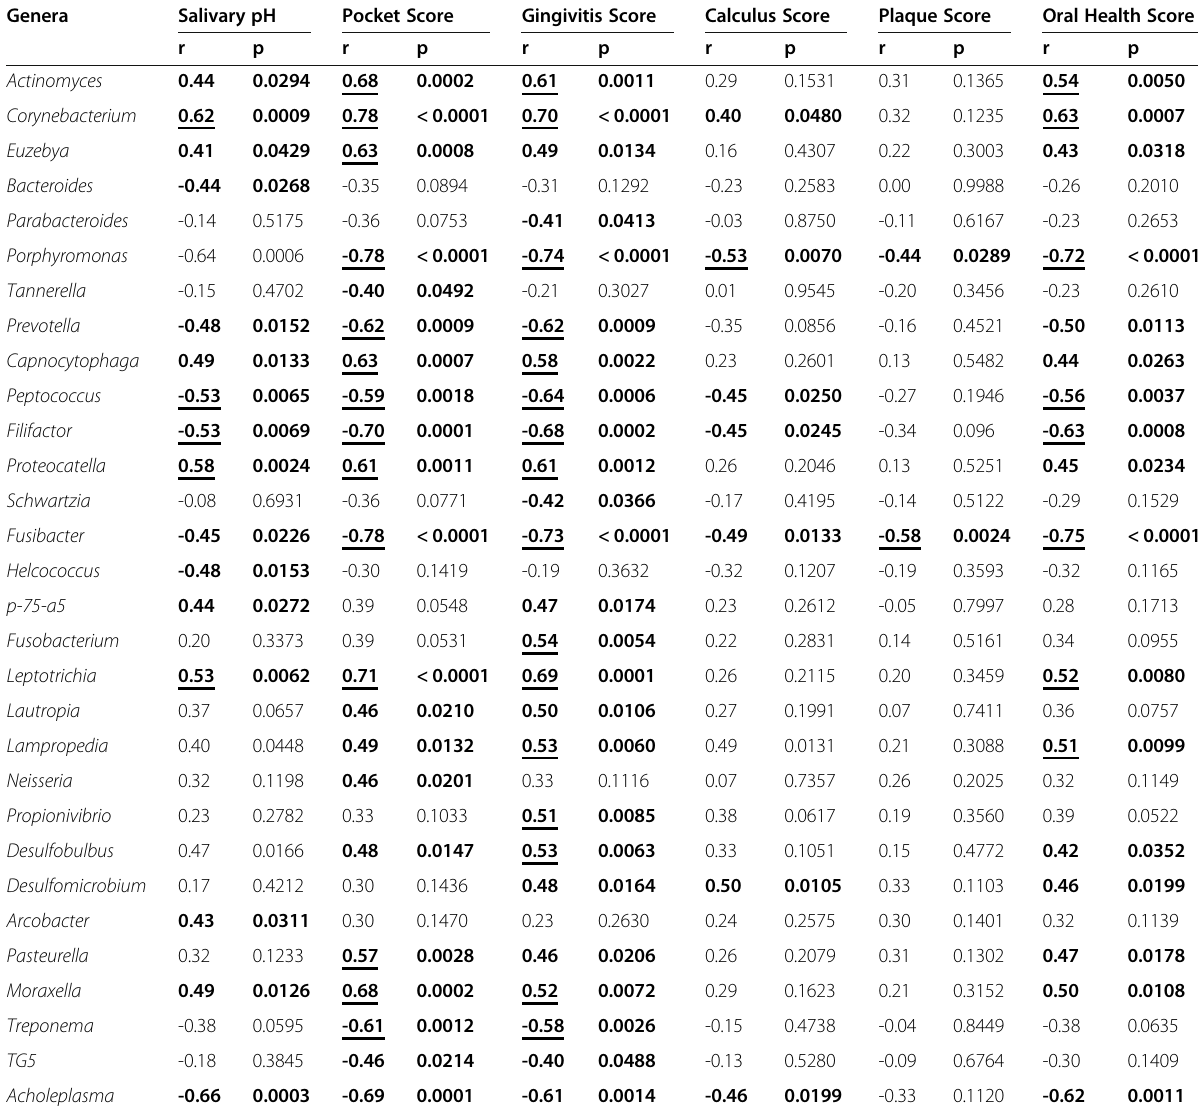
Table 7 Correlation coefficients (r) between oral health scores, plaque scores, calculus scores, gingivitis scores, pocket scores, pH and bacteria genera in subgingival samples